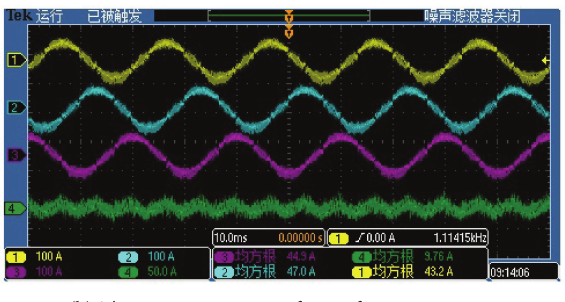
Figure 11: The experimental waveforms before and after compensa-